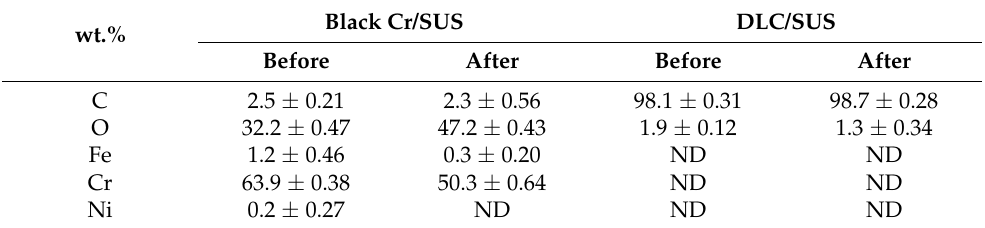
Table 4. Surface element analysis of samples using energy-dispersive spectroscopy (EDS).